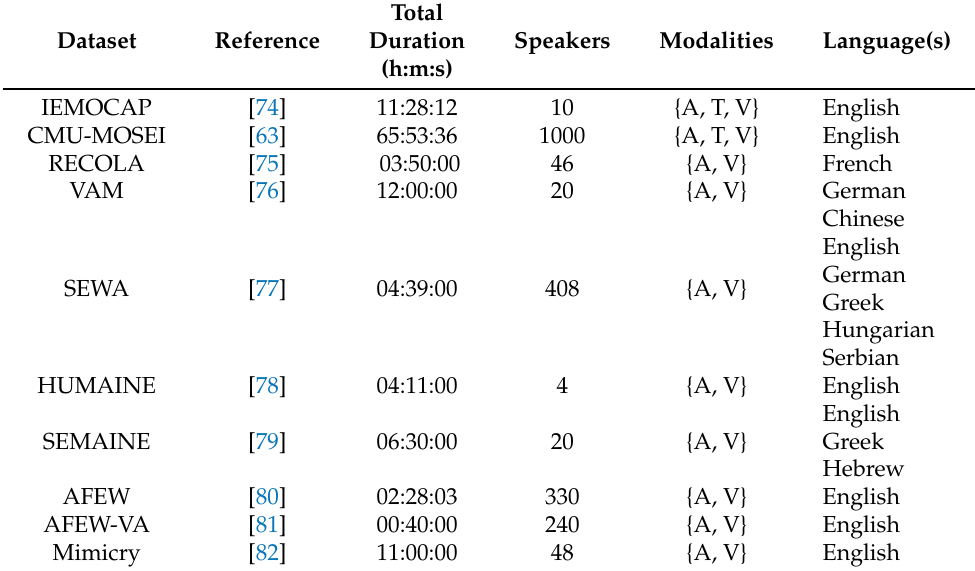
Table 1. Widely used multimodal emotion recognition